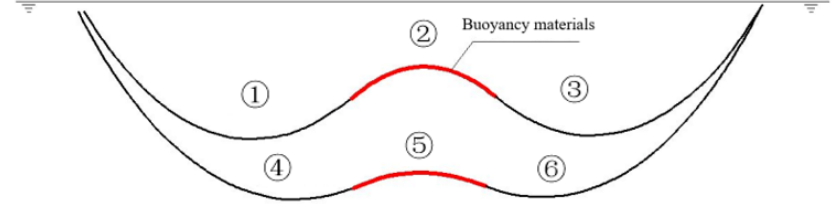
Figure 3. Schematic diagram of the oil offloading lines.